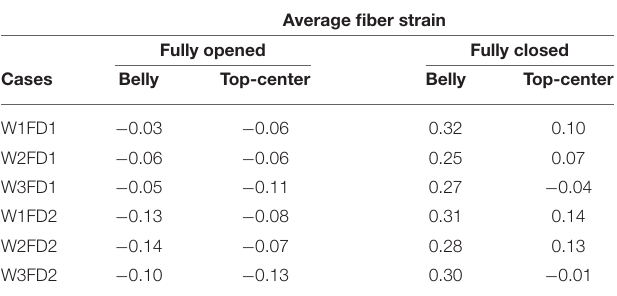
TABLE 5 | Average fiber strain of aortic valve (AV) with six different cases.